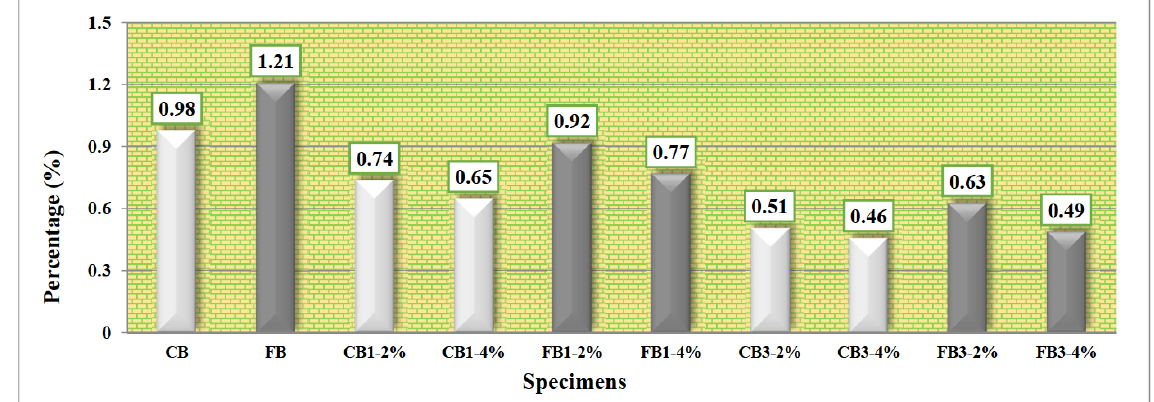
Figure 8: Percentage of ballast material abrasion